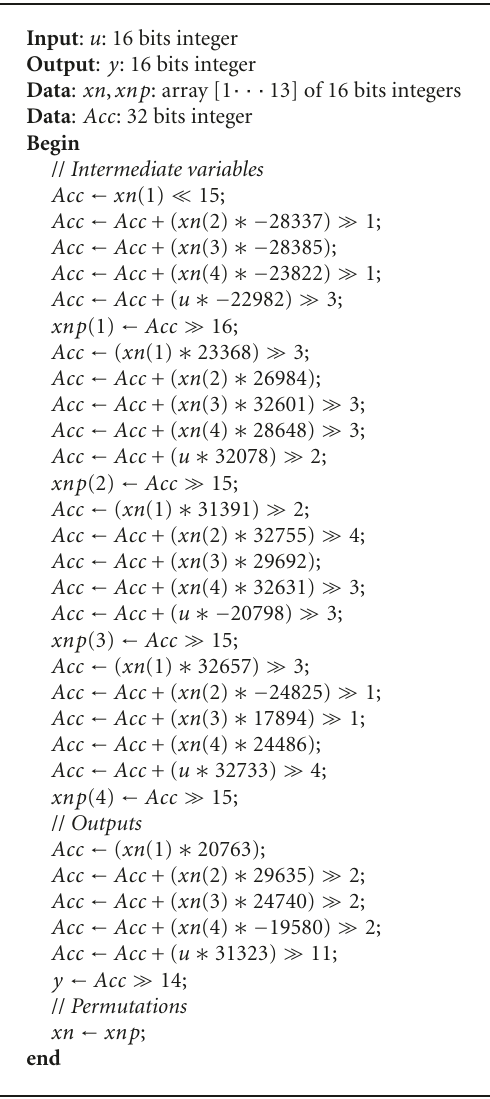
Algorithm 1: Z 5 implemented in 16-bit fixed